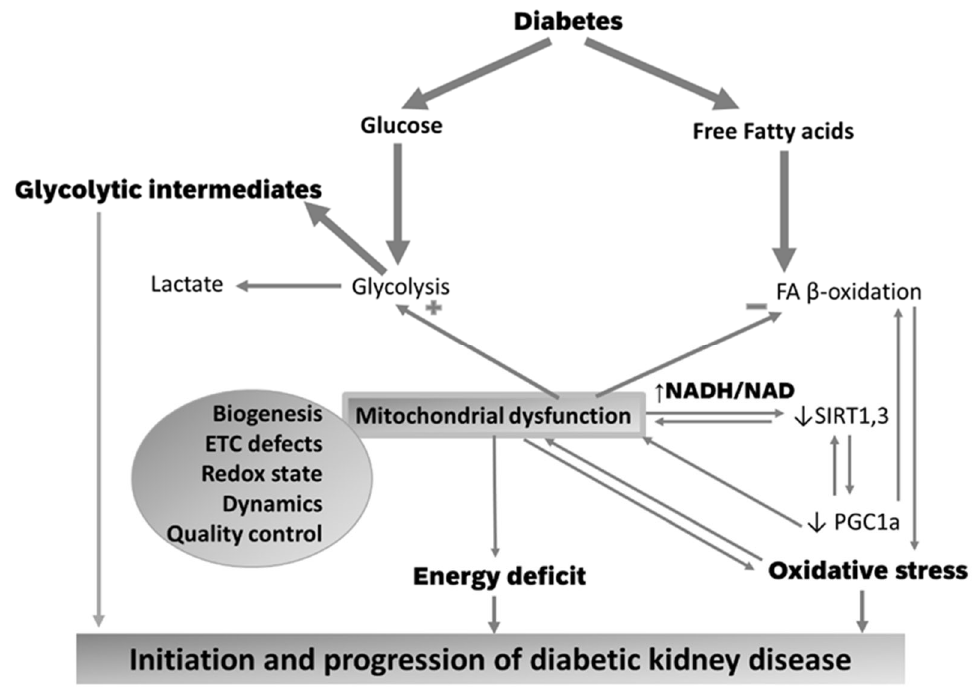
Figure 3. Excessive energetic substrates in diabetes leads to mitochondrial defects that cause reduc ‐ tive stress, oxidative stress, and energy deficit. Decreased insulin activity in diabetes provides an excess of circulating energetic substrates (i.e., glucose, free fatty acids) that enter the kidney cells by an unregulated route and are used in metabolism. An increase in the glycolytic flux that is not matched by an active mitochondrial oxidative phosphorylation leads to an accumulation of glyco ‐ lytic intermediates that follow alternative metabolic pathway in the cytosol, which are responsible for inflammation, fibrosis, and epigenetic changes. The increased fatty acid (FA) oxidation observed in early diabetes, which is driven by PGC1 α overexpression, leads to increased mitochondrial oxi ‐ dative stress. During more advanced diabetes, mitochondrial defects limit FA oxidation and in ‐ crease the NADH/NAD redox ratio (reductive stress) that restrains the mitochondrial lysine deacetylase, sirtuin 3 (SIRT3) activity. SIRT3 deacetylates and activates FA oxidation enzymes, ETC components, and PGC1 α . Mitochondrial dysfunction has multiple pathogenic mechanisms includ ‐ ing decreased PGC1 α ‐ mediated mitochondrial biogenesis and posttranslational modifications of mitochondrial proteins (oxidation, lysine acetylation).